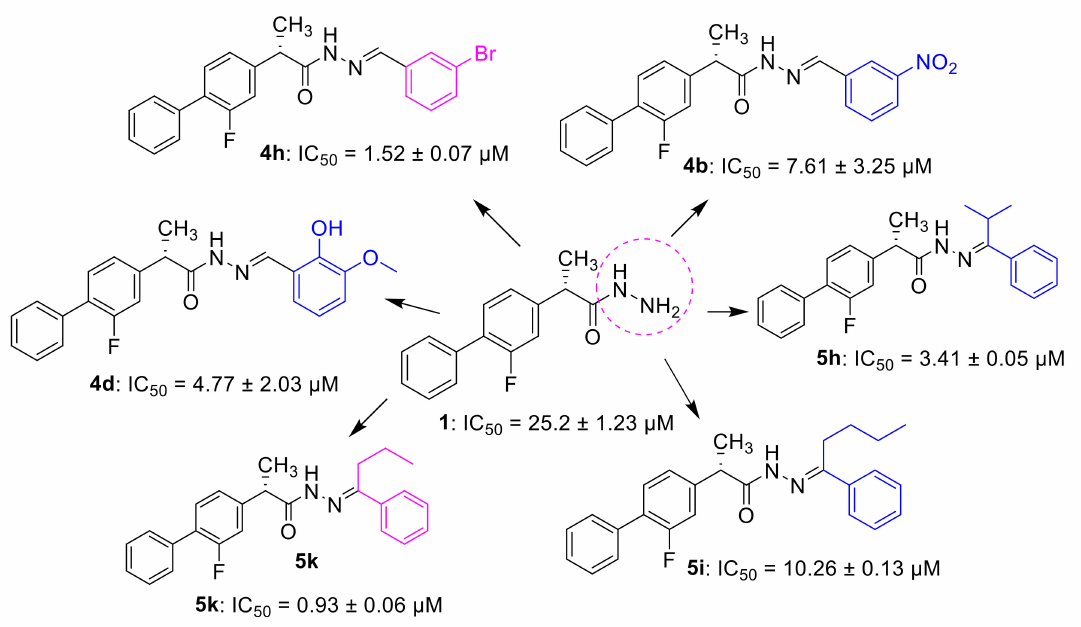
Figure 2. Substitution influence on the Schiff’s base derivatives of